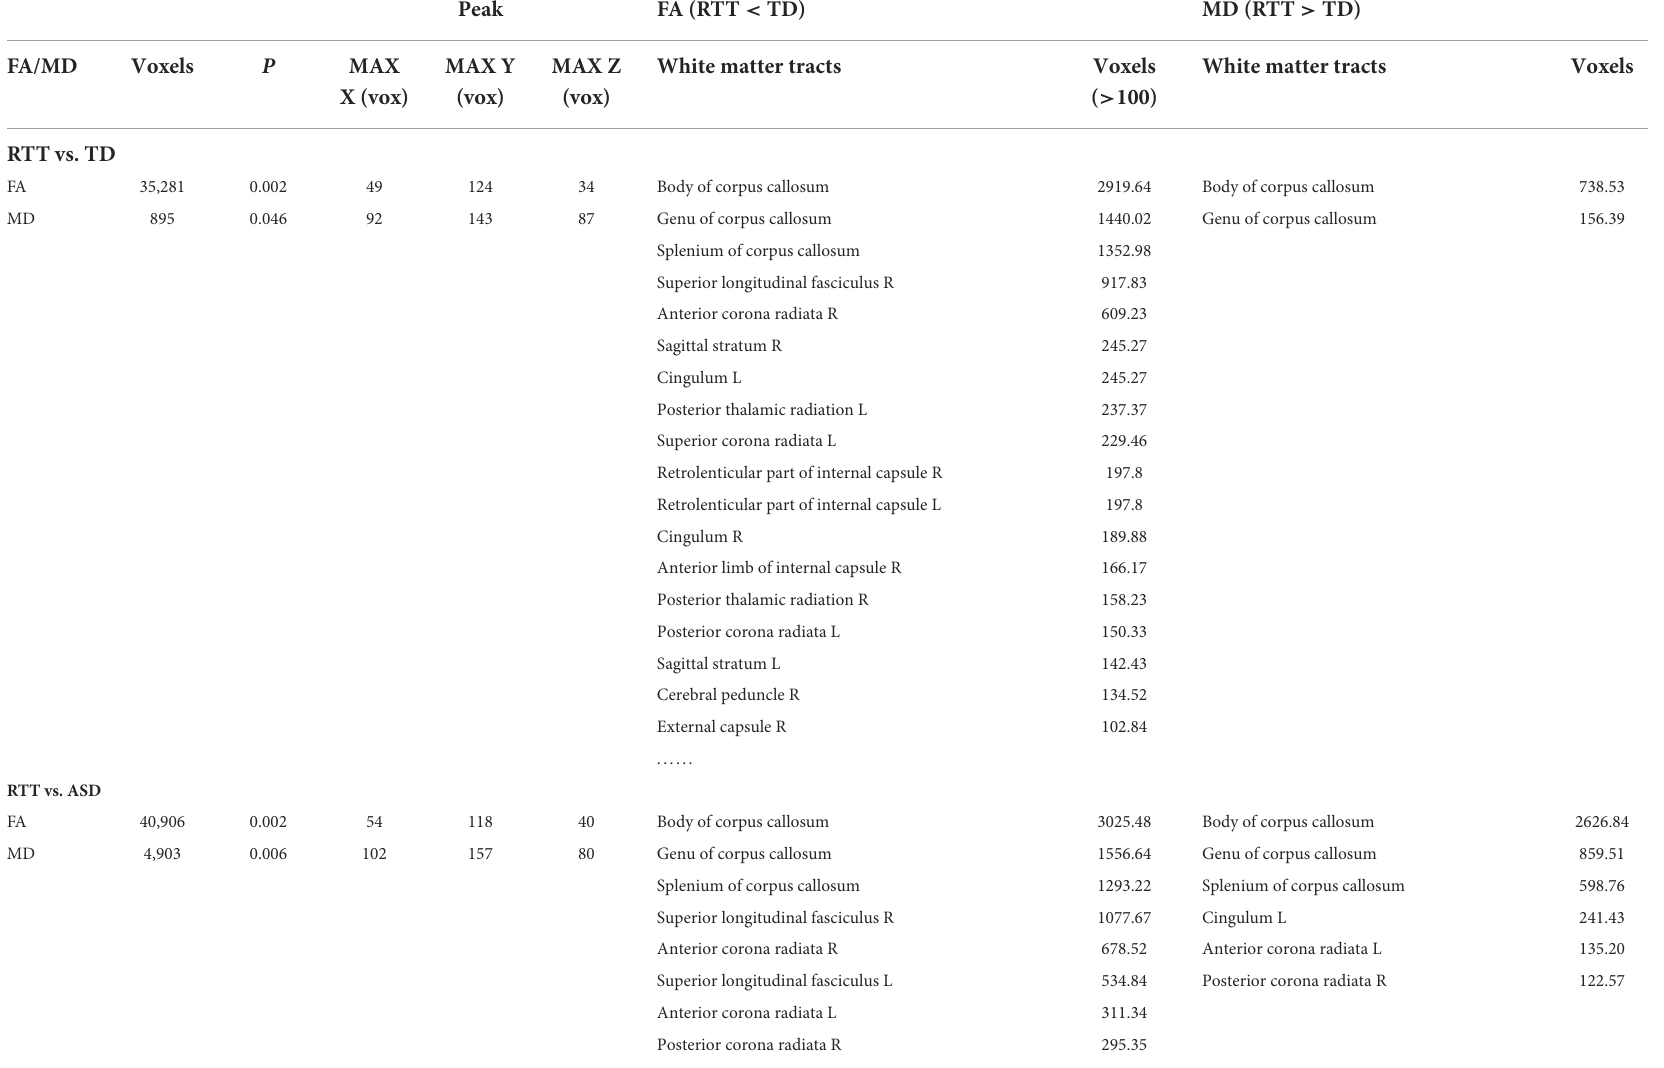
TABLE 3 Decreased FA and increased MD values in comparisons between the RTT group and controls for TBSS analysis.